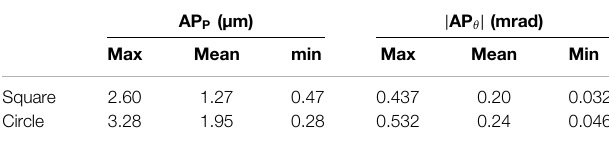
TABLE 4 | Positioning and orientation accuracies (respectively AP P and AP θ ) of the robot for two different trajectories. AP P